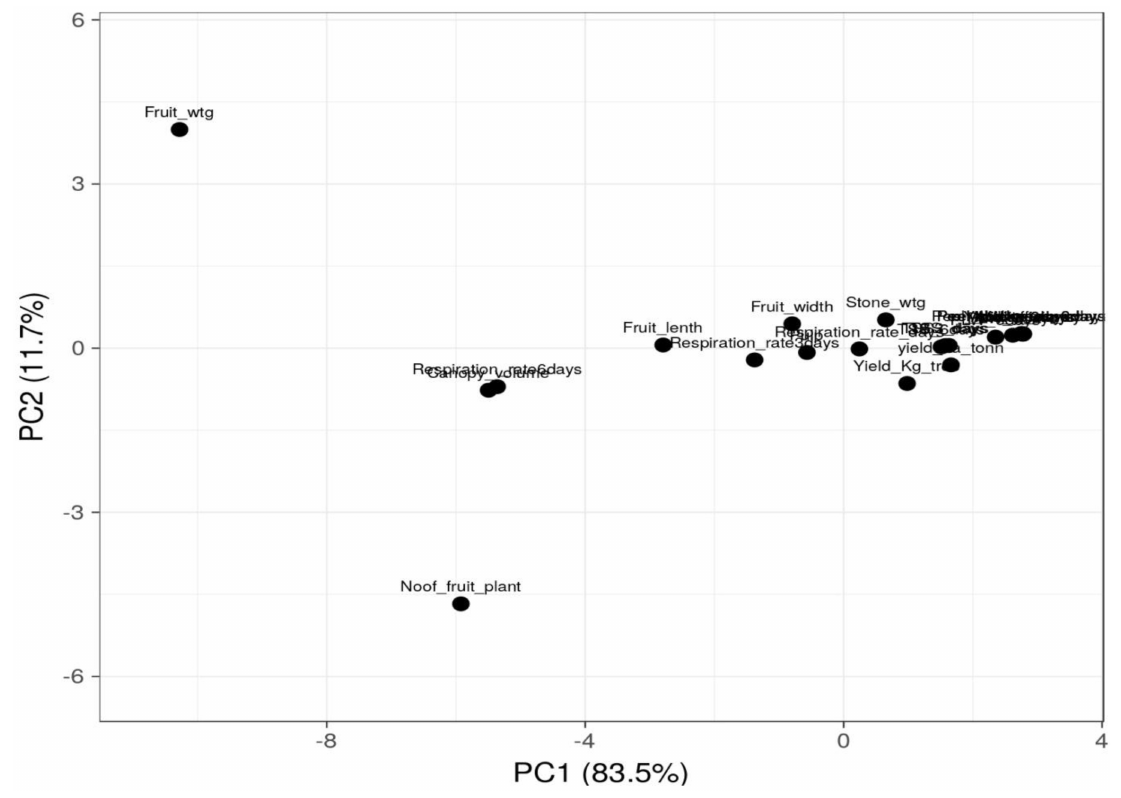
Figure 3. PCA (Principal component analysis) biplot for fruit quality traits of scion/rootstock combinations in mango varieties.